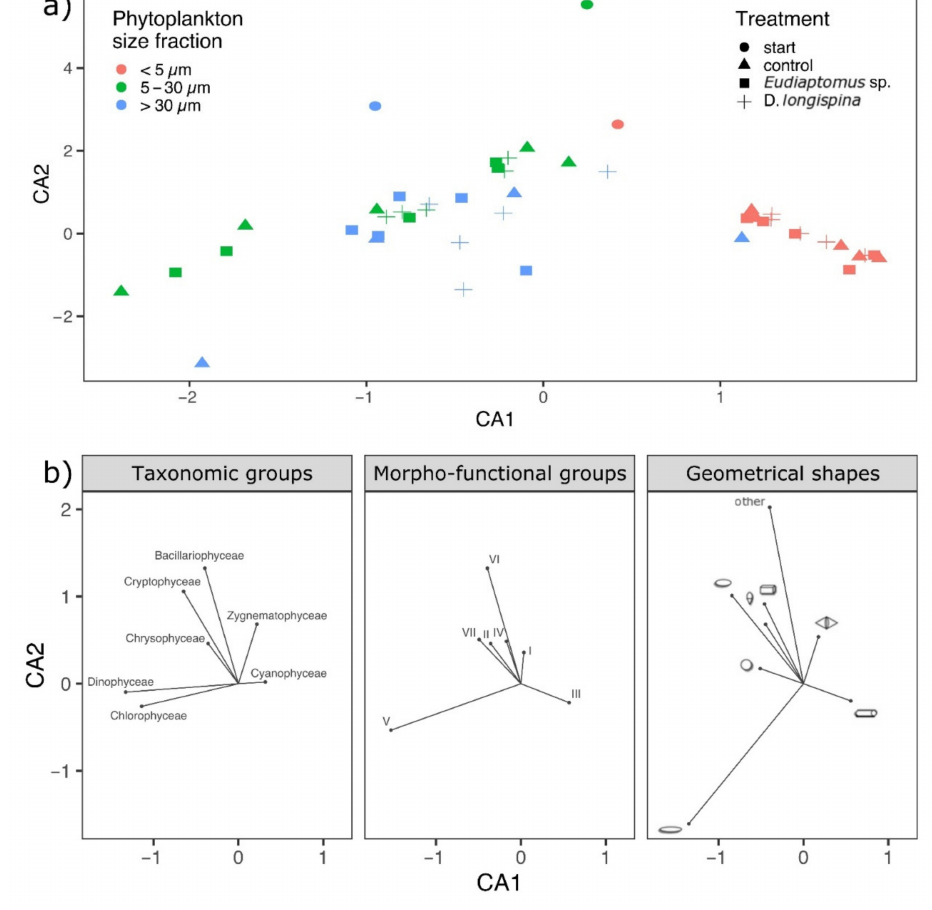
Figure 3. Ordination plot resulting from a correspondence analysis (CA), ( a ) main biplot with the mean phytoplankton trait abundance composition according to treatments and size fractions represented by different symbols and colors respectively, ( b ) plots for taxonomic, morpho-functional and geometrical shape based groups with relative